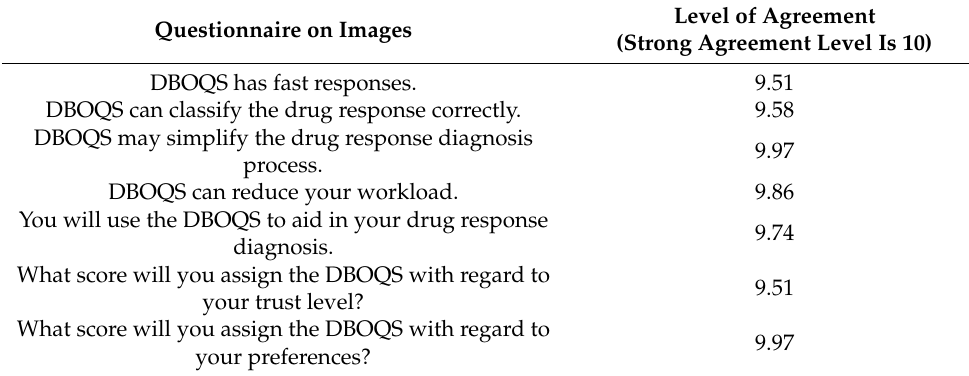
Table 13. Questionnaire result from 30 doctors who were trying to use DRCS. Level of Agreement Questionnaire on Images (Strong Agreement Level Is 10) DBOQS has fast responses. 9.51 DBOQS can classify the drug response correctly. 9.58 DBOQS may simplify the drug response diagnosis process. DBOQS can reduce your workload.